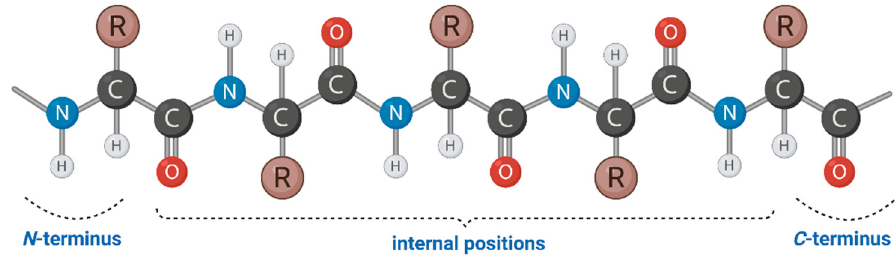
Figure 1. Schematic representation of the three different positions of an amino acid in a peptide chain. Created with Biorender.com.